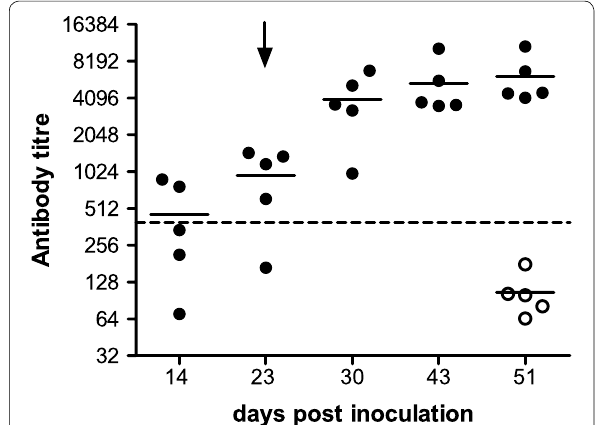
Fig. 2 Humoral immune response elicited by SVP. Nineteen-day-old chickens were immunized with SVP (closed circles) or control sample (open circles) on days 0 and 23 and bled at 0, 14, 23, 30, 43, and 51 days post-inoculation. Sera were evaluated for the presence of specific antibodies against IBDV with a commercial kit (IDEXX Laboratories, Inc., USA). Titres above 396 were considered positive as indicated by the manufacturer’s instructions (dashed line). Black lines indicate the mean of the antibody titre. Arrow indicates boost vaccination